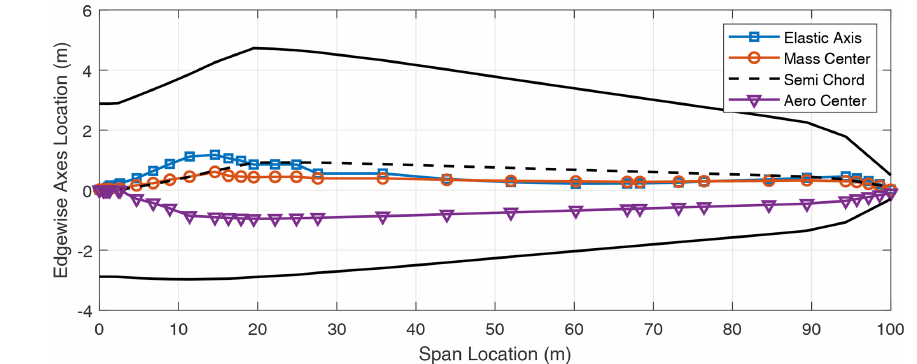
Figure A4. Planform for the SNL100-00 turbine blade.